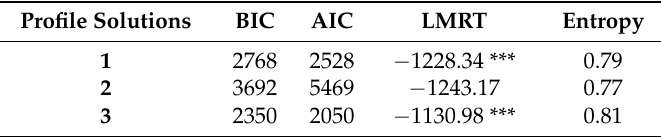
Table 1. Model fit indices for the 1, 2 and 3-profile solutions. The best-fitting statistical solution indicates lower BIC and AIC values and a significant LMRT value. All entropy values showed an ideal fit. *** p < 0.001.